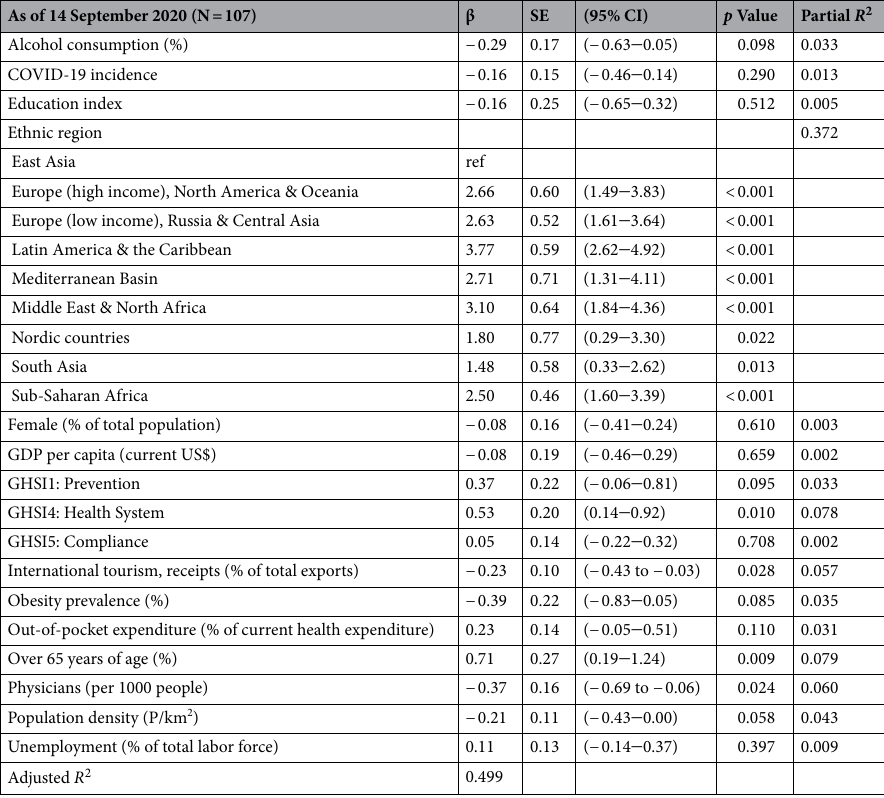
Table 5. Multiple linear regression analysis on log transformed COVID-19 case-fatality ratio. β beta coefficients, SE standard error, 95% CI 95% confidence interval, COVID-19 incidence total confirmed cases of COVID-19 per one million population, GDP Gross Domestic Product, GHSI Global Health Security